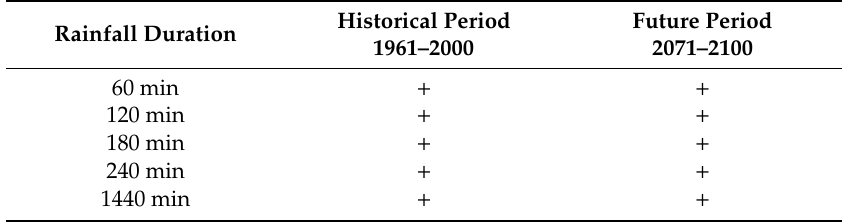
Table 6. Trend analysis of short-term rainfall intensities for the Vyšná Boca climatological station— Boca River basin.